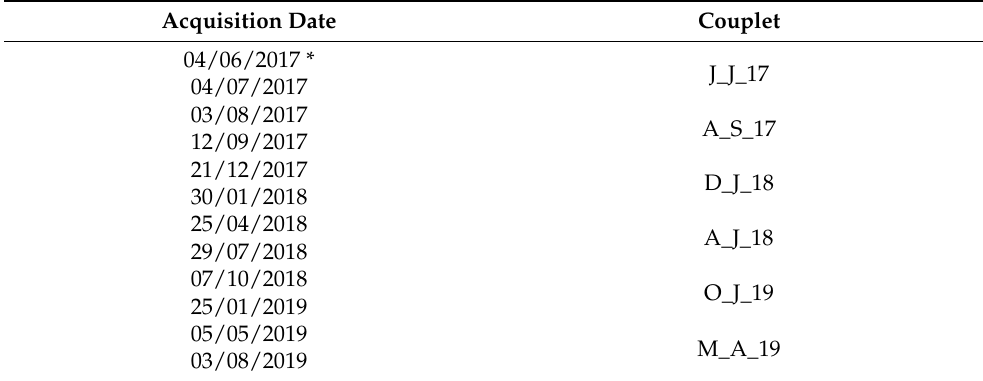
Table 3. Sentinel-2 images acquisition date and couplets (* pre-fire